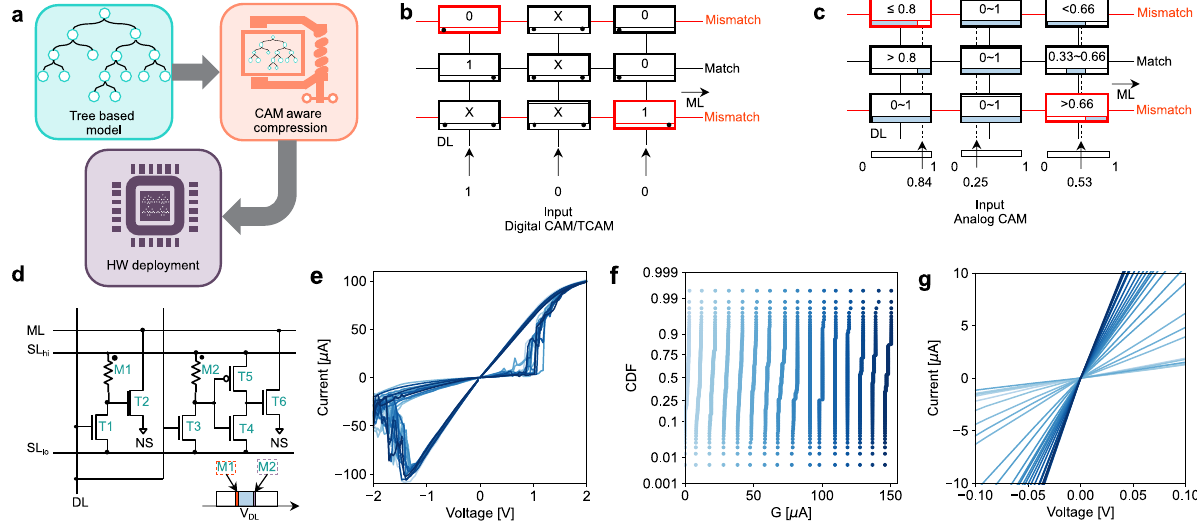
Fig. 1 Analog content addressable memory with memristor. a Illustration of this work, tree-based machine learning models are optimized and deployed on analog CAM hardware. b Digital ternary content addressable memory (TCAM), which searches a given input word across the whole memory and outputs the location of a match. c Analog CAM, where each cell stores ranges of values, or multi-bit representations. An analog input word is searched against the whole memory array in parallel, similar to the digital TCAM. d Circuit schematic of an analog CAM with memristor. e Memristor current – voltage (I – V) characteristics for different cycles. f Cumulative density functions of 16 levels of conductance corresponding to 4 bits of information, each